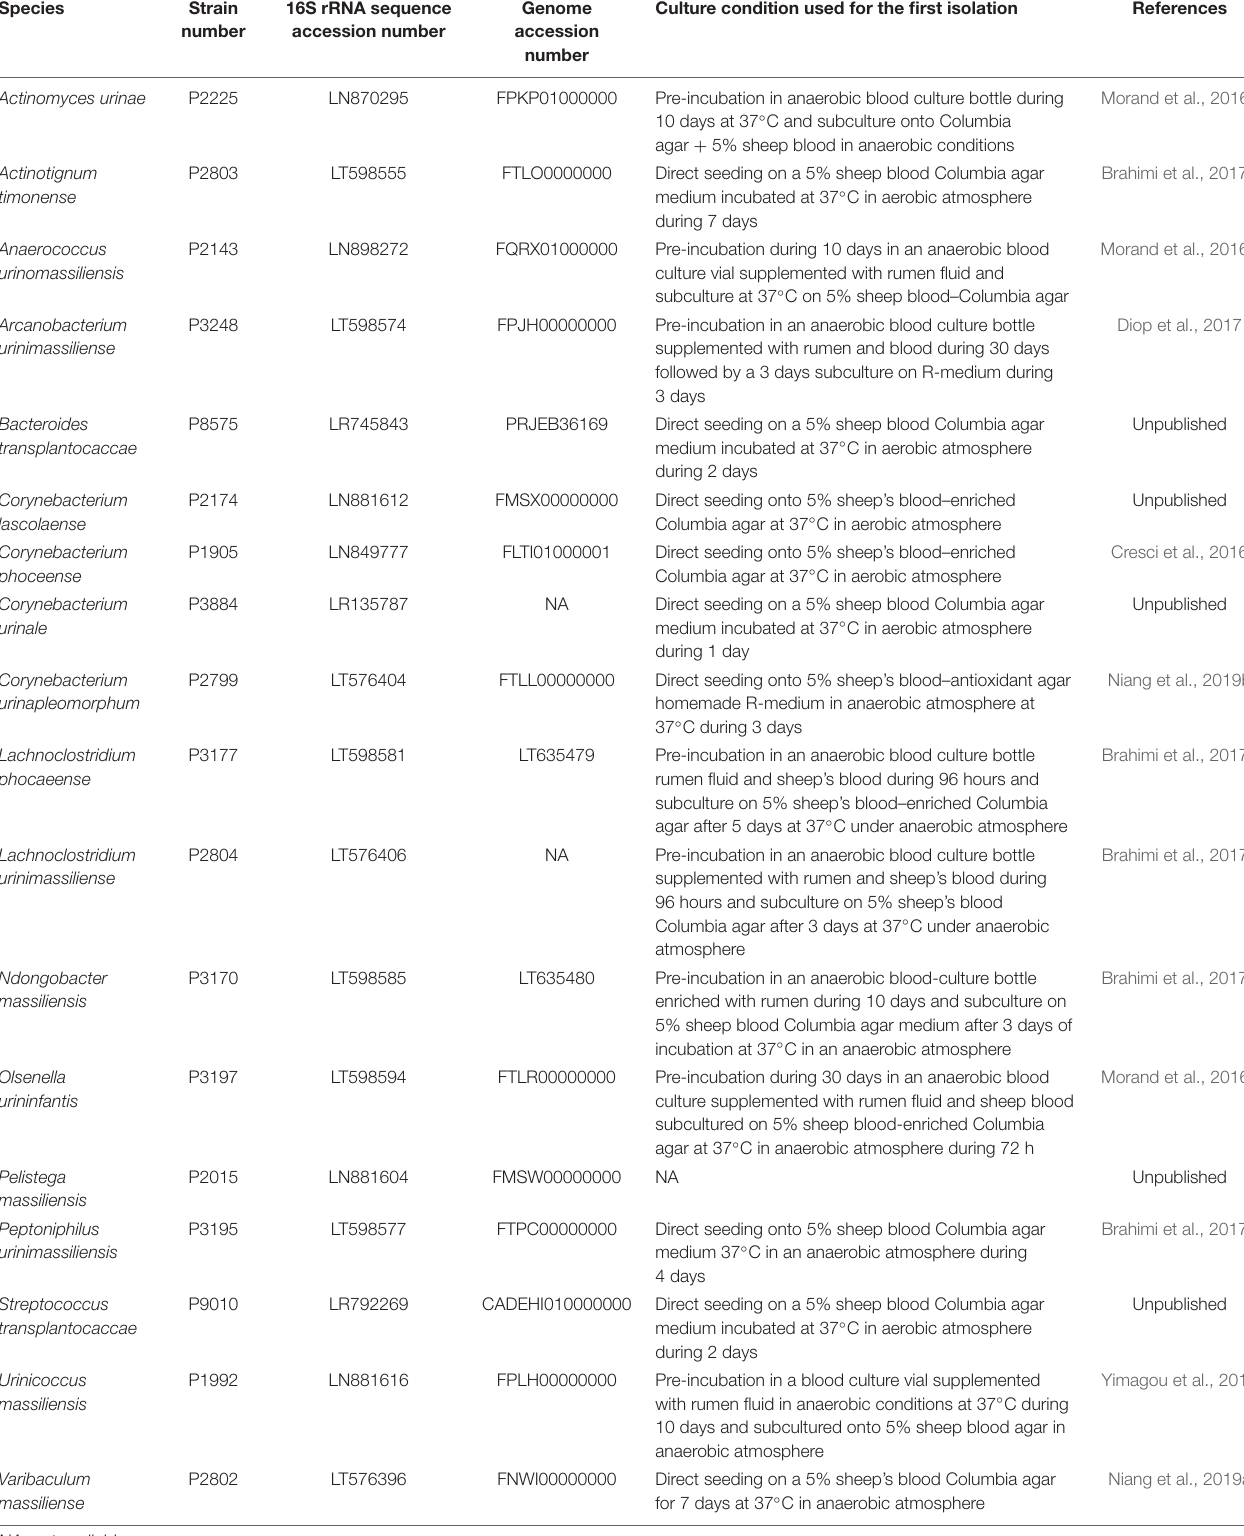
TABLE 2 | Main characteristics of the 18 new species isolated as a part of this study including strain collection deposit number, 16S rRNA sequence accession number, genome accession number (when available), and culture conditions required for primo-isolation and reference (when available).